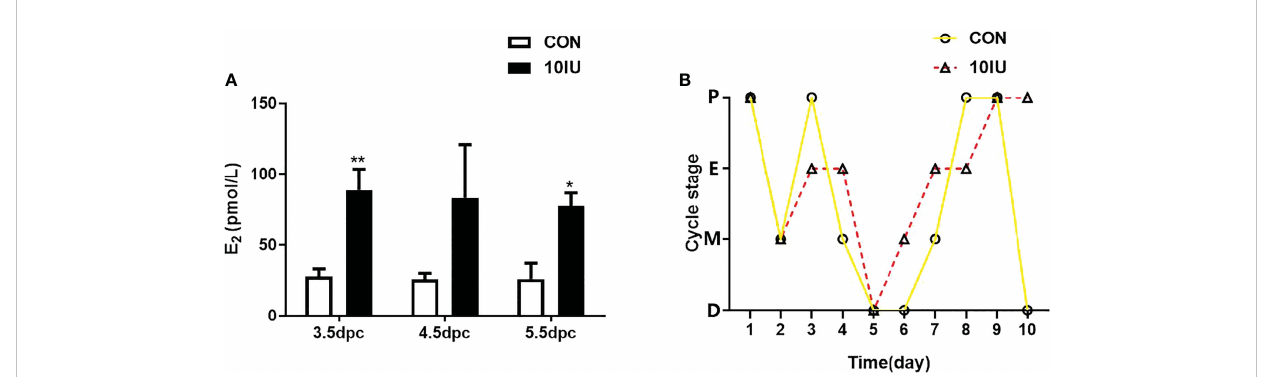
FIGURE 2 Serum oestrogen level and oestrus cycle changes between the CON and 10 IU groups. (A) Serum oestrogen levels of mice in the CON and 10 IU groups during the peri-implantation period. (B) Changes in the oestrous cycle of the mice in the CON and 10 IU groups. The abscissa depicts the number of days of detection, and the ordinate depicts the oestrus cycle. P: pro-oestrus, E: oestrus, M: meta-oestrus, D: dioestrus. Compared with the control group, *p<0.05,